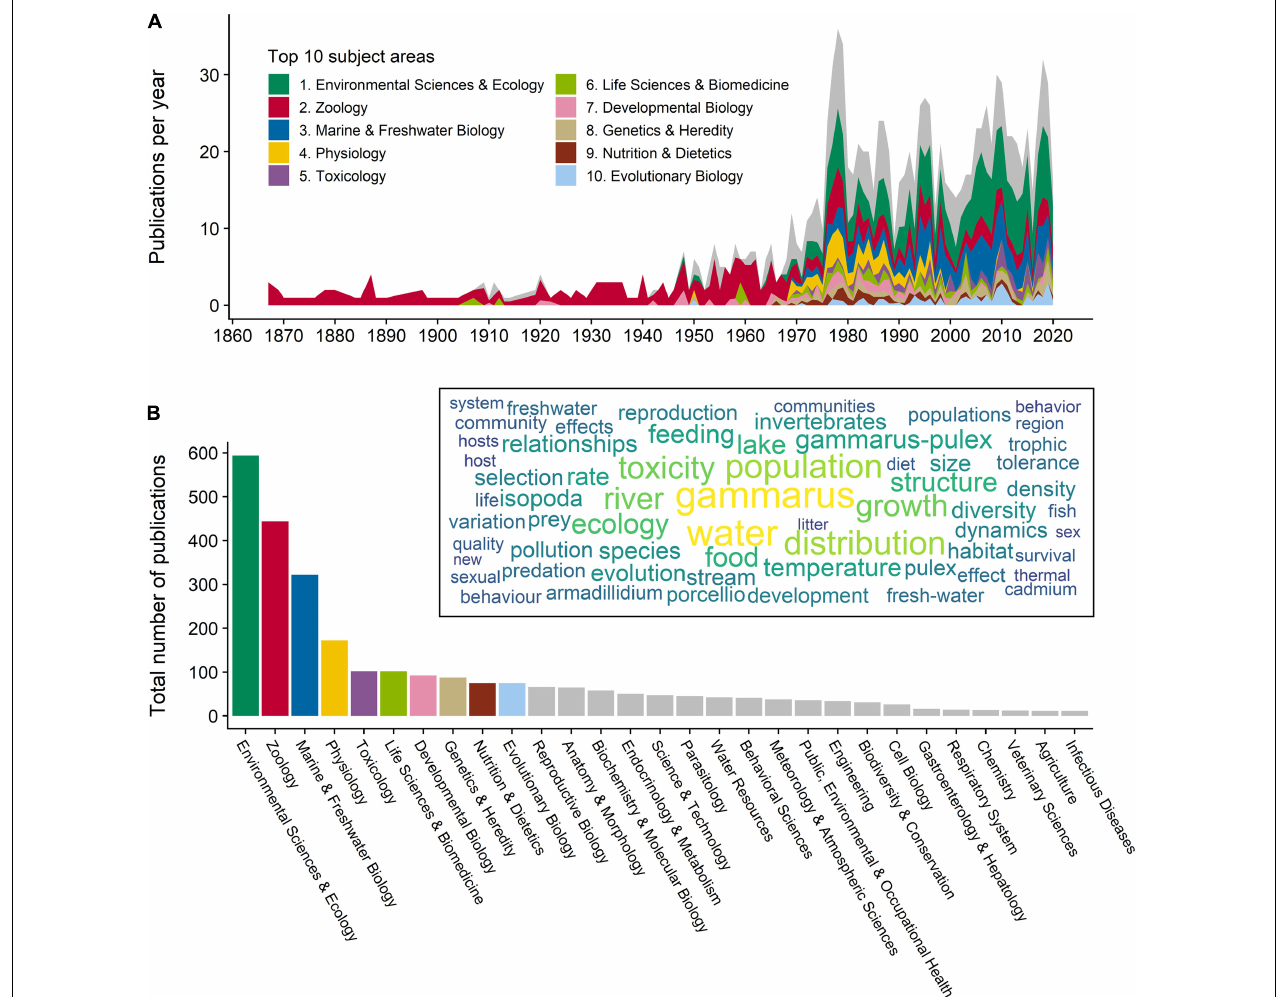
FIGURE 1 | Over 150 years of research on and with Asellus aquaticus . The figure summarizes published scientific literature on A. aquaticus . We conducted a quantitative literature survey with the search tools of Web of Science (WOS; Clarivate analytics) by searching for the term “asellus aquaticus” in six databases (i.e., BIOSIS, CABI, FSTA, Medline, WOS Core Collection, and Zoological Records). We found 1235 records, published between 1867 and 2020. (A) The graph shows the number of publications per year within a given subject area, as designated by WOS. (B) The graph shows the total number of publications assigned to a specific subject area. The top 10 fields account for 72.58% of all publications, and are indicated by color coding in (A,B) (multiple assignments are possible, summing up to 2845 assignments). The inset in (B) shows a wordcloud with the 100 most used keywords from all A. aquaticus publications. Furthermore, we compiled all records with relevant information (e.g., title, keywords, research areas, and abstract) to a single file which is available online (Zenodo DOI: https://zenodo.org/record/5070310#.YV1LQx1S_zU). More details can be found in the Supplementary Material